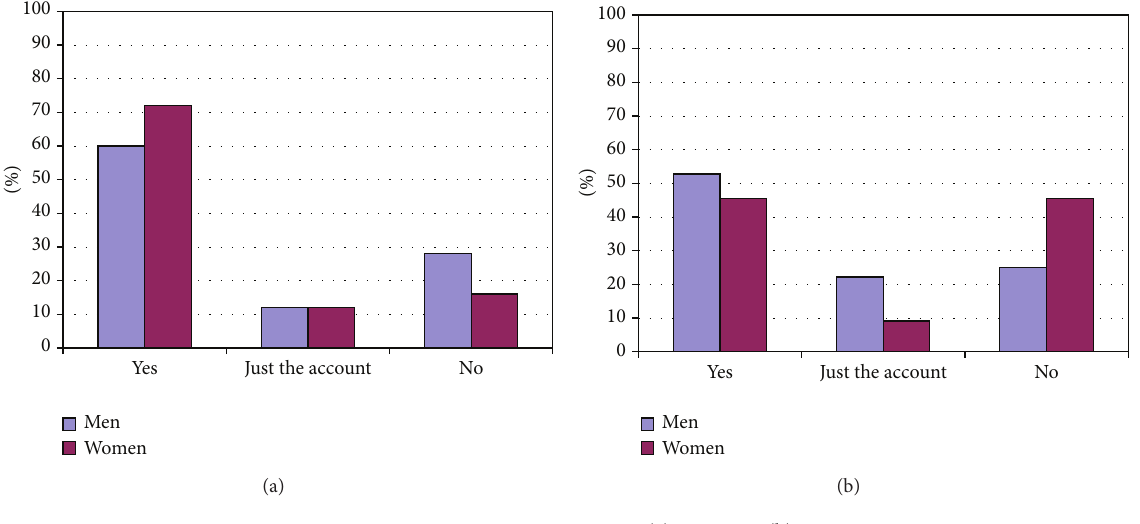
Figure 5: Instagram presence: DN (a) versus DI (b).